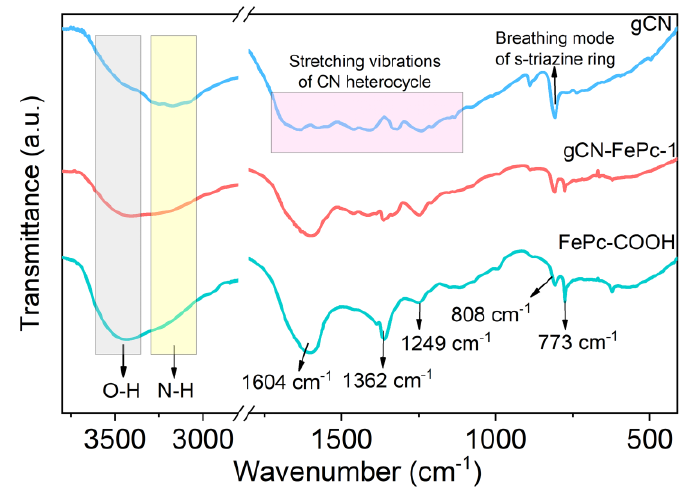
Figure 3. FTIR spectra of different samples.